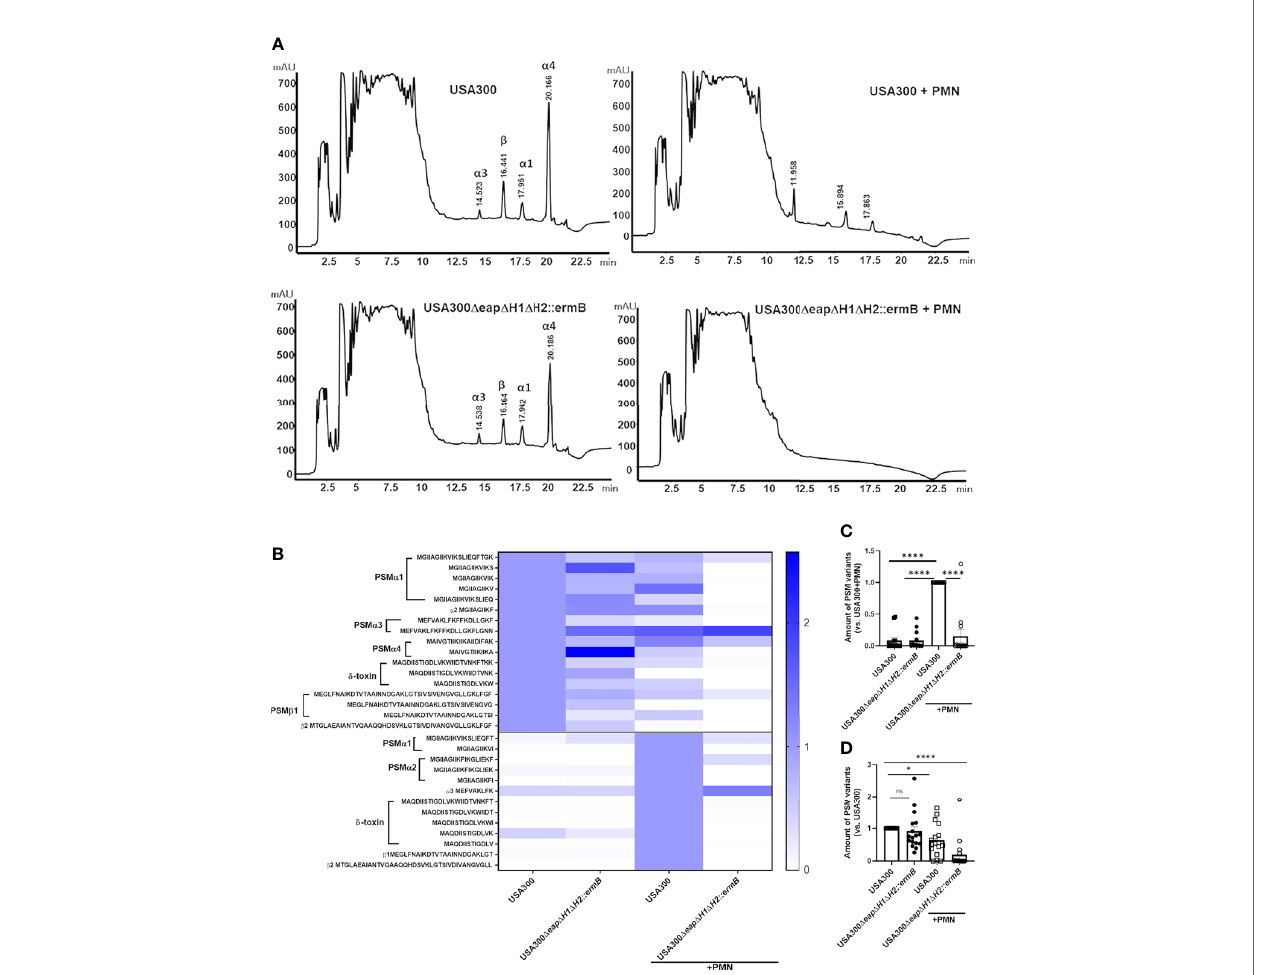
FIGURE 5 | NSPs enhance degradation of PSMs by neutrophils in culture fi ltrates of USA300. No pre-incubation or prior incubation of culture fi ltrates of wild-type USA300 with neutrophils for 24 h leads to disappearance of original peaks representative for a and b -PSMs in the HPLC chromatogram, but also to the appearance of new peaks. Treatment of culture fi ltrates of USA300 D eap D H1 D H2::ermB with neutrophils only leads to disappearance of nearly all peaks representative for PSMs (A) . Heat map of HPLC/MS Analysis of neutrophil-treated or untreated culture fi ltrates show that incubation of USA300 indeed leads to disappearance of a few PSM fragments, found in untreated culture fi ltrates, but also to the appearance of new fragments. In neutrophil-treated culture fi ltrates of the USA300 D eap D H1 D H2::ermB mutant most truncated fragments are absent. Heat map represents data normalized towards USA300 (above the line) or towards USA300 plus neutrophils (below the line) (B) . C-terminally truncated PSM fragments with highest abundance in neutrophil-treated culture fi ltrates of USA300 (C) or PSM fragments with highest abundance in untreated culture fi ltrates of USA300 (D) . Data represent mean and SEM of three different culture fi ltrates of USA300 or USA300 D eap D H1 D H2::ermB , each incubated with or without neutrophils of two different donors. ns, not signi fi cant, *P < 0.05; ****P < 0.0001 signi fi cant difference versus USA300+neutrophils (C) or USA300 (D) as calculated by one-way ANOVA with Dunnett ’ s multiple comparisons